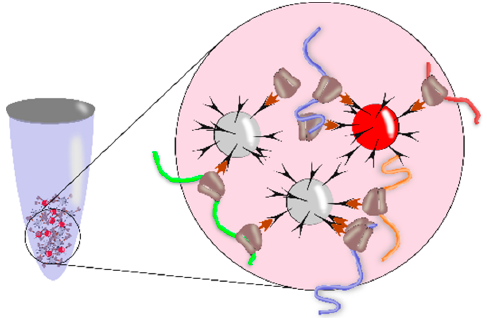
Figure 2. Polysome profiling using translating ribosome affinity purification (TRAP). General principle of selective separation on anti-FLAG-M2 agarose of the transcripts bound to ribosomes carrying the epitope-tagged variant of ribosomal protein. Brown arrows denote the FLAG epitope in ribosomal protein and black icons denote the anti-FLAG on agarose beads.